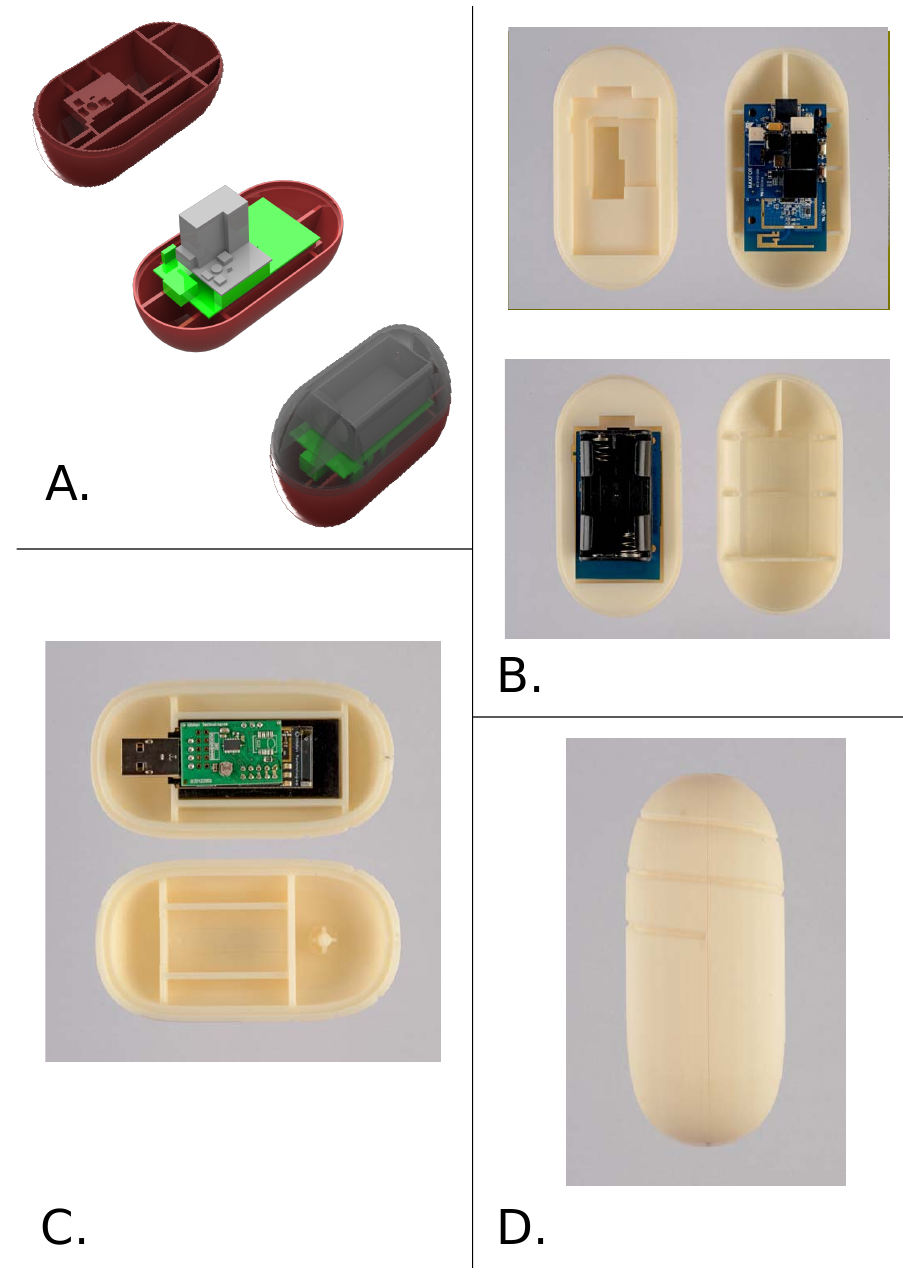
Figure 2. The development of internal case: ( A ) The sensor is accommodated rigidly by the internal structure of the case, matching the structure of the sensor, shown here for the CM4000 sensor-mote; ( B,C ) The final 3D printed case fits the sensor accurately, keeping the overall assembly compact and minimizing the movement of the sensor (examples for CM4000 (B) and G-node (C)); ( D ) Modifications can be made to accommodate special features, such as the modified antenna of the G-node, which can be secured within the spiral sculptured into the external surface of the case constructed for the G-node